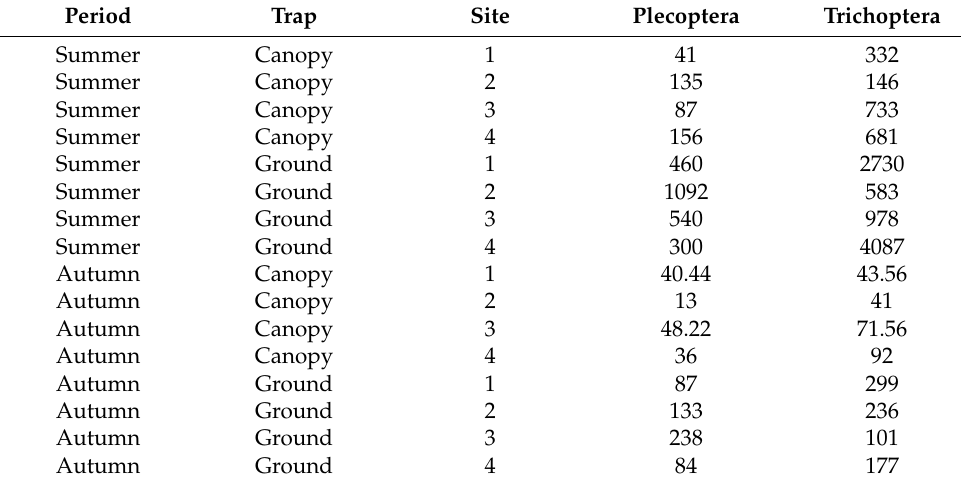
Table 2. Abundances of Plecoptera and Trichoptera between trap type and sampling periods per 14 days. Autumn canopy traps at Sites 1 and 3 sampled for 9 days due to trap failures, and abundances were rescaled to abundance per 14